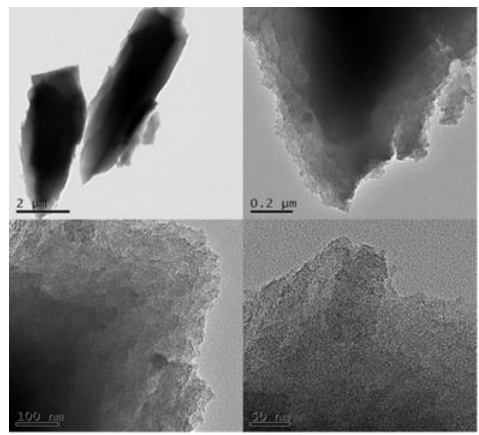
Figure 2. TEM images of SF−HPC .